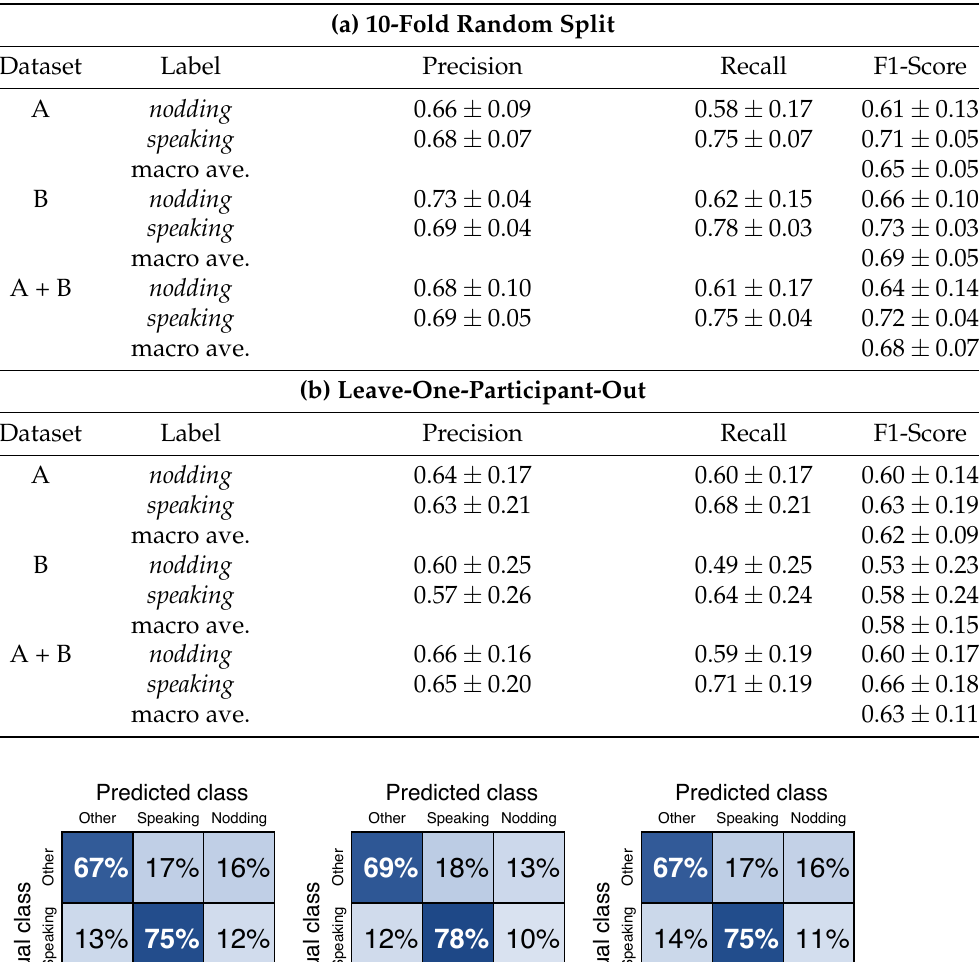
Table 2. Prediction Result of Nodding and Speaking for Offline Meeting.